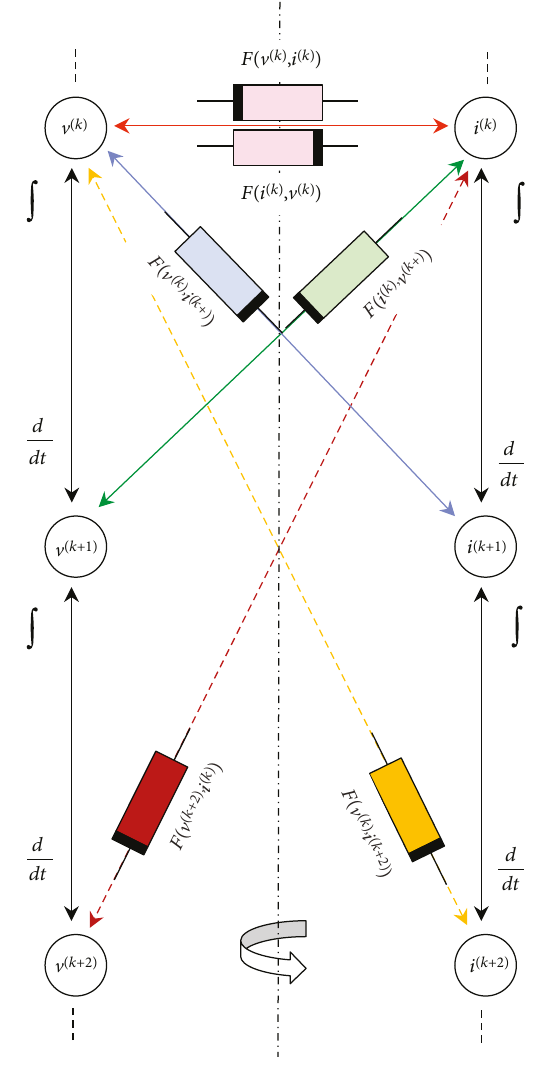
Figure 3: Classical dual elements can be considered as a result of the “ fl ip-type ” transformation in the storeyed structure: each element has its dual counterpart, which appears in the structure after fl ipping the image of the original element along the dot-and-dash vertical line. The same holds for the current nodes, which are dual to the voltage nodes and vice